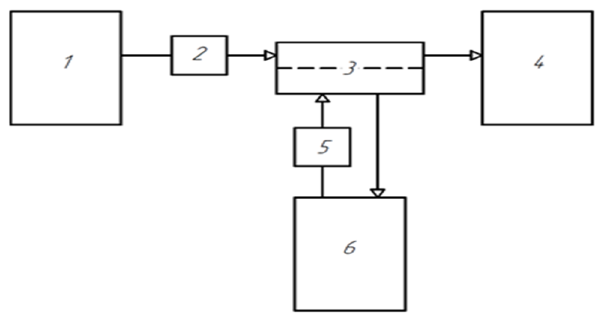
Figure 2. Diagram of the installation for measuring water permeability and the rejection. 1—the storage tank with the initial solution; 2—the ultrafiltration pump; 3—the ultrafiltration module; 4—the retentate and regenerate storage tanks; 5—the regeneration pump; 6—the storage tank for the filtrate (permeate).